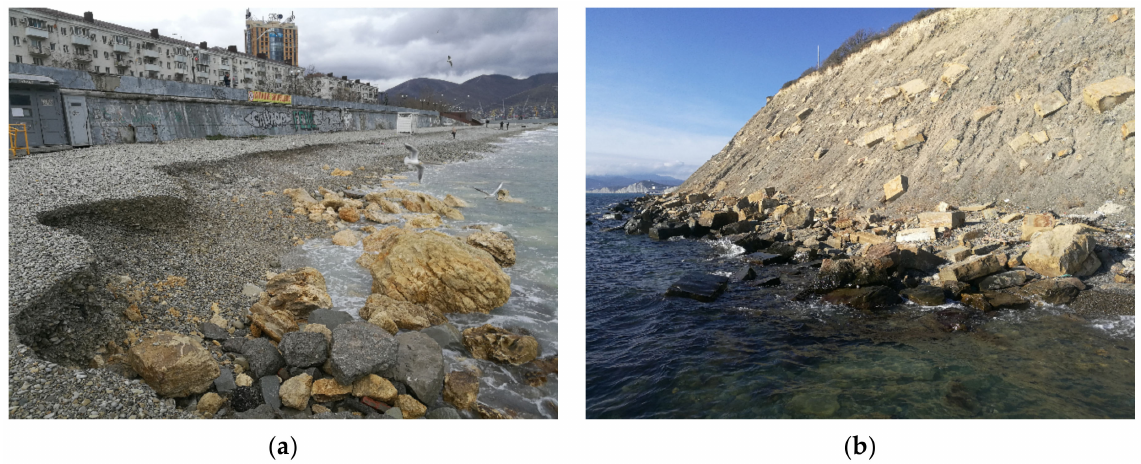
Figure 15. ( a ) Beach erosion in the City of Novorossiysk after a winter storm on 28 January 2021; ( b ) coast erosion in Shirokaya Balka near Novorossiysk due to landslide and talus processes, 4 February